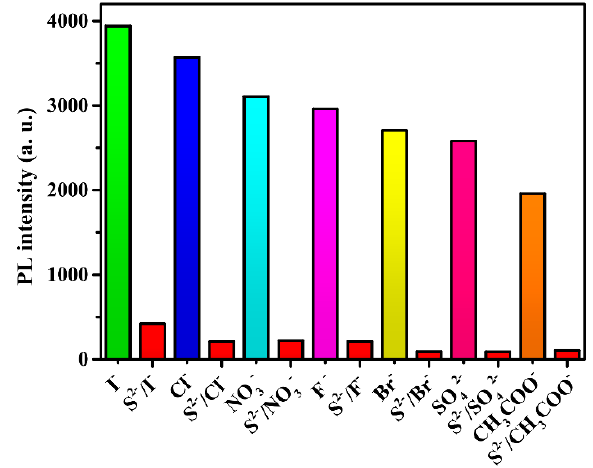
Figure 12. Luminescence intensities of 2 responding to interfering ions in the course of detecting S 2 − ions.